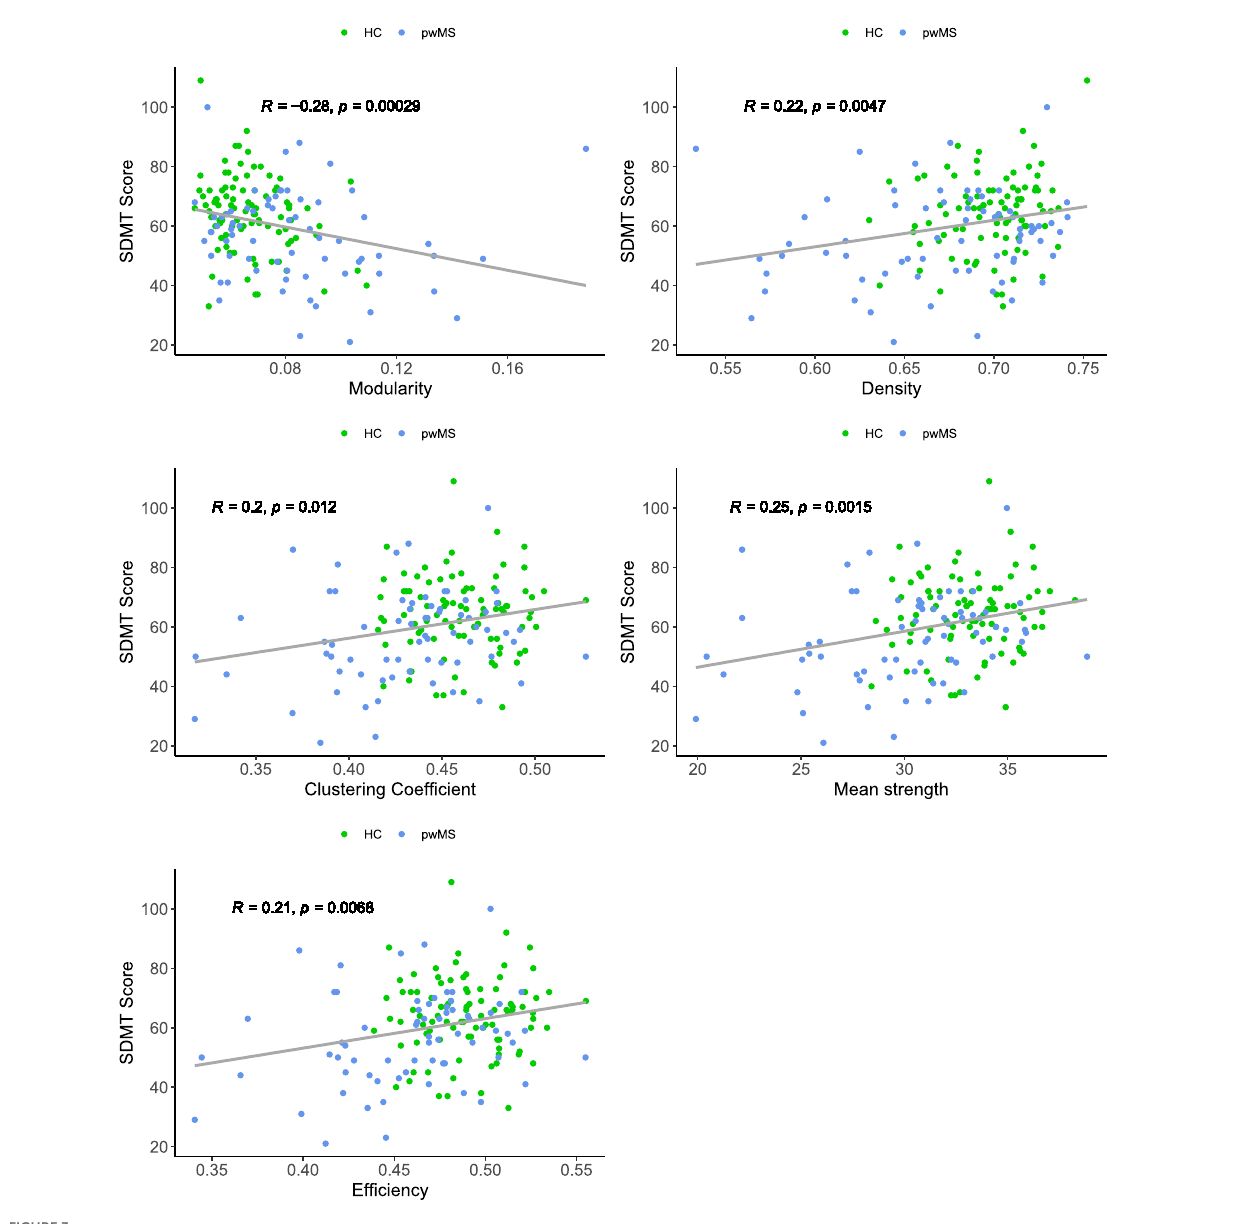
FIGURE3 Scatter plots between symbol digit modalities test (SDMT) score and global network metrics, color-coded for the two groups [patients with multiple sclerosis (pwMS) and healthy controls (HC)]. Spearman’s correlation coefficient suggests an association between each global network metric and information processing speed in all participants. Correlations are positive for density, clustering coefficient, mean strength and efficiency, and negative for